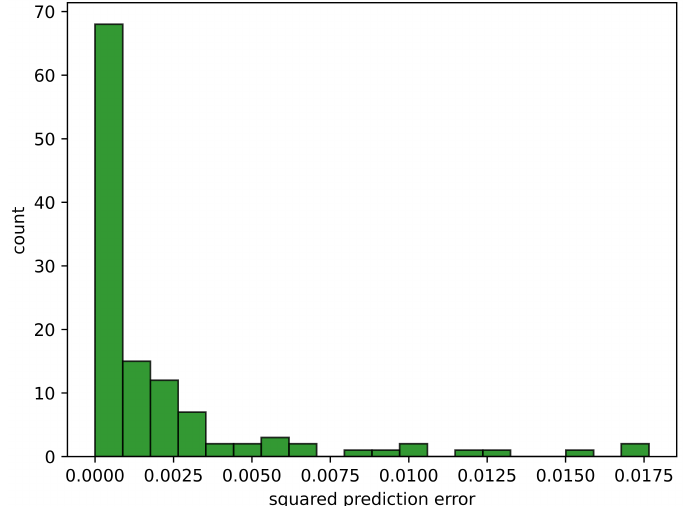
Figure 6. Histogram of squared prediction error for all 10 stocks in